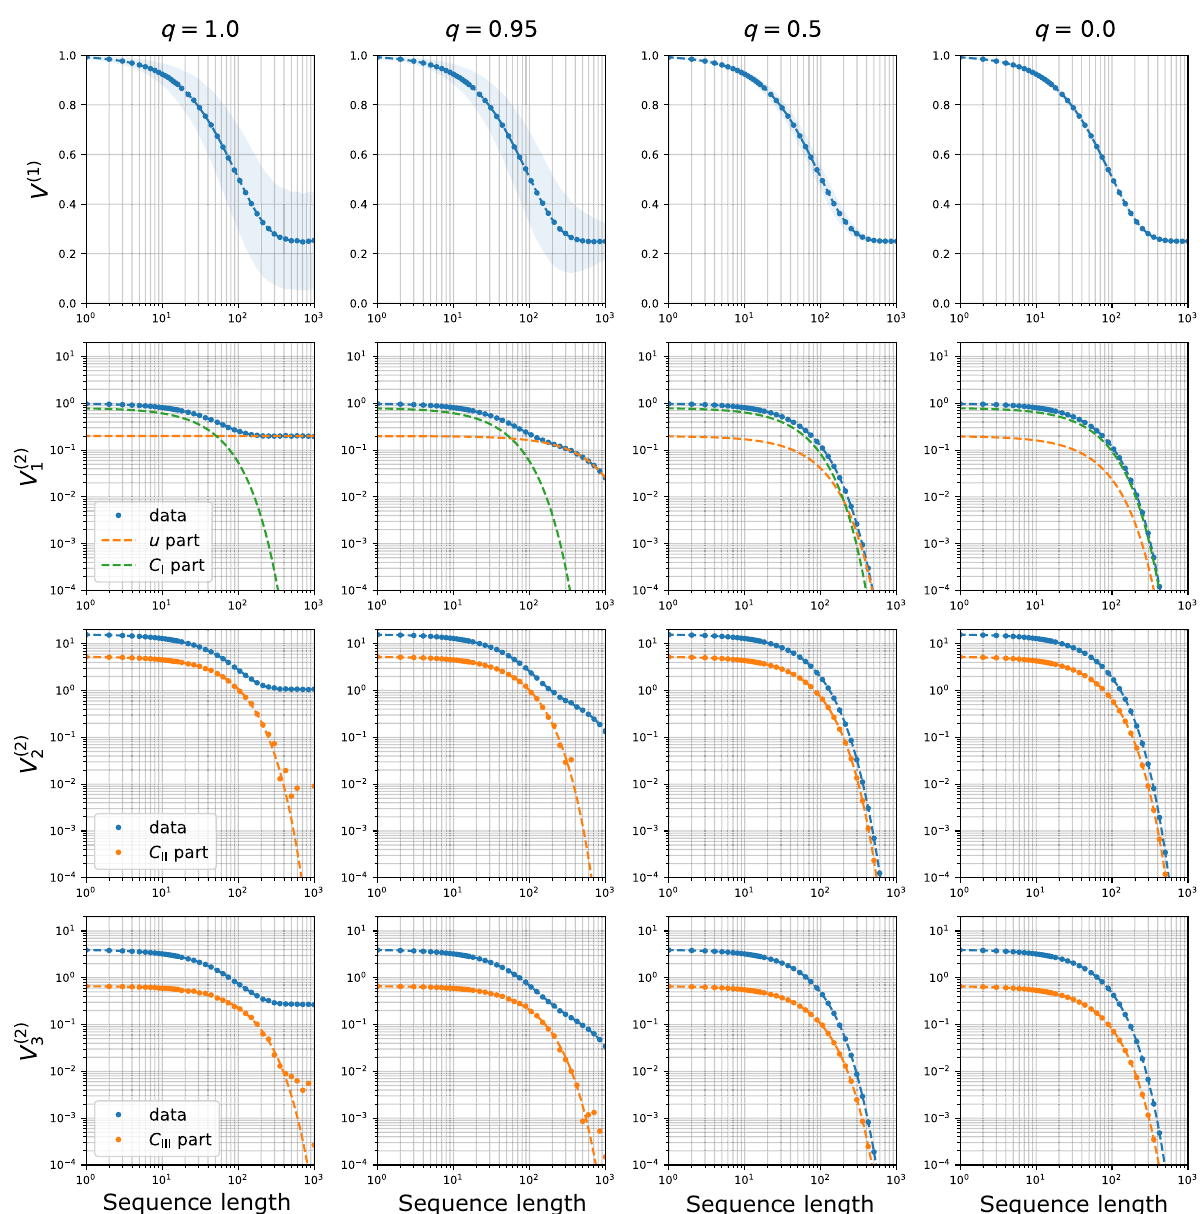
FIG. 8. A step-by-step fitting process of 2-RB for two-qubit systems are shown. The first line of the matrix are about the standard RB (1-RB). The second, third, and fourth lines show 2-RB with two, three, and four exponentially decaying functions, respectively. The initial and measurement operators for 2-RB are chosen according to Table I. See the main text for